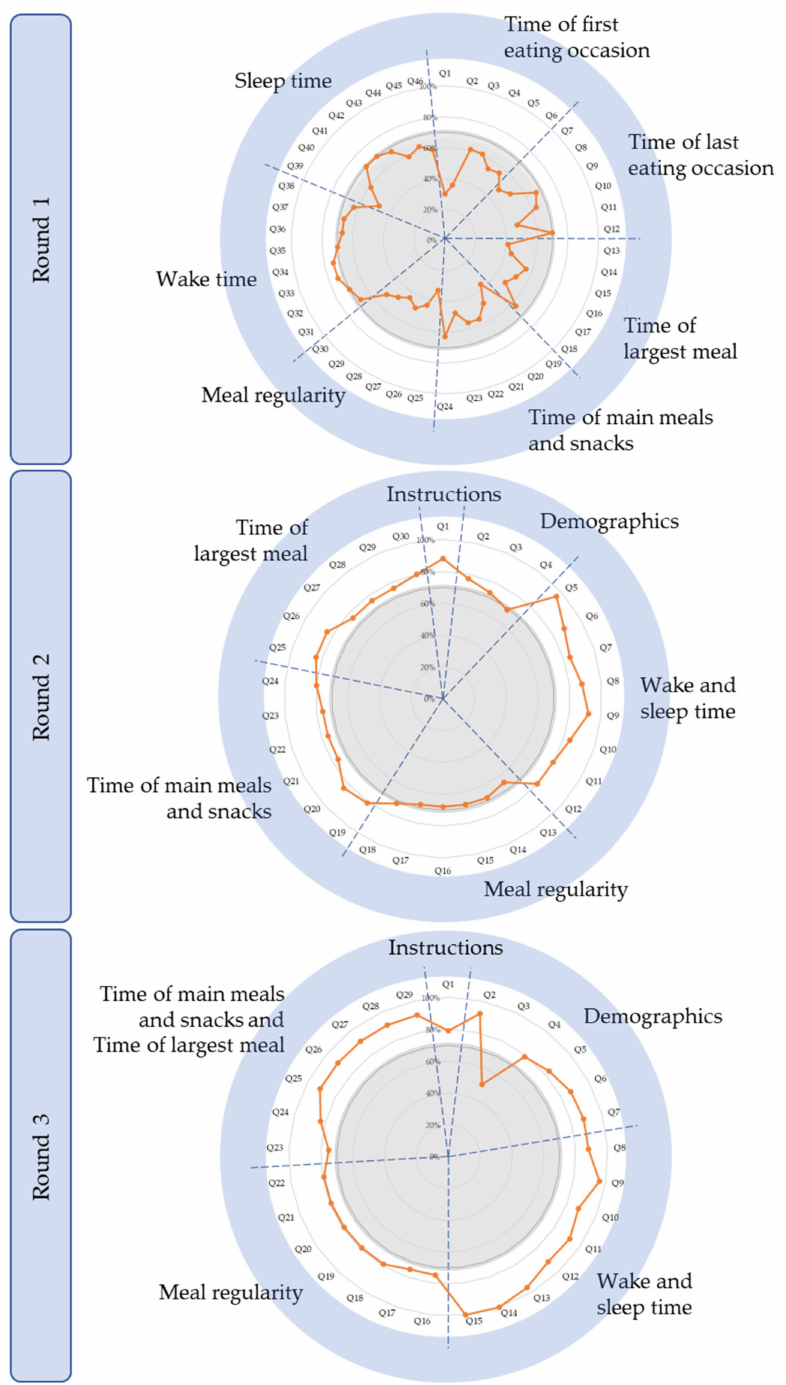
Figure 4. Chrononutrition Questionnaire sections, respective questions, and percentage ratings of relevance by experts in Delphi Rounds 1–3. The dashed blue lines segregate sections within the questionnaire, showing questions within each section; the grey areas represent ≤ 70% consensus; and the orange lines show ratings of relevance by experts. Note that the order of sections from Rounds 1 to 3 was modified based on feedback from experts to provide the most logical